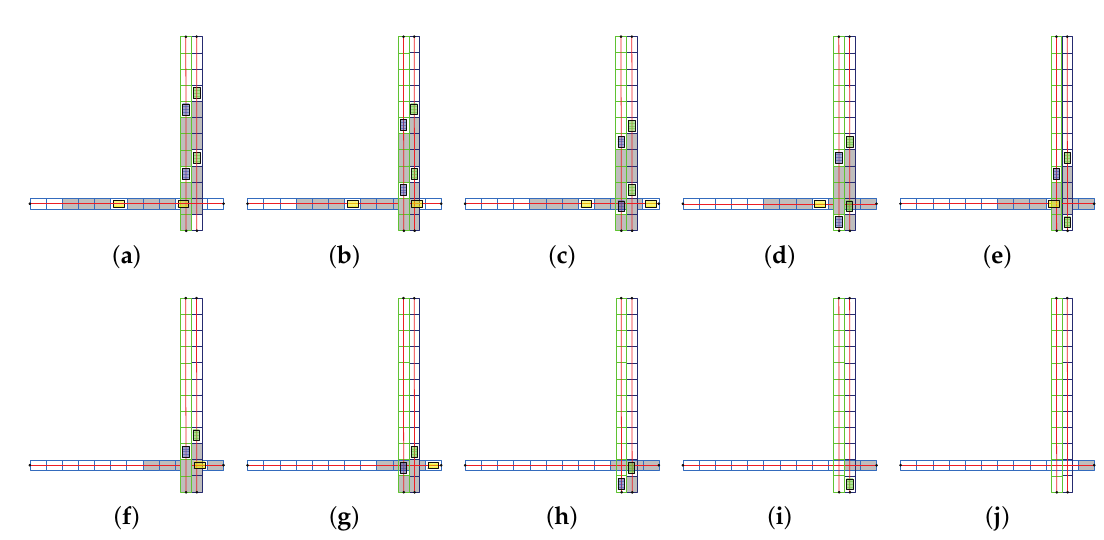
Figure 16. Transfer of CAVs, ( a ) t = 3 s, ( b ) t = 6 s, ( c ) t = 9 s, ( d ) t = 12 s, ( e ) t = 15 s, ( f ) t = 18 s, ( g ) t = 21 s, ( h ) t = 24 s, ( i ) t = 27 s, ( j ) t = 30